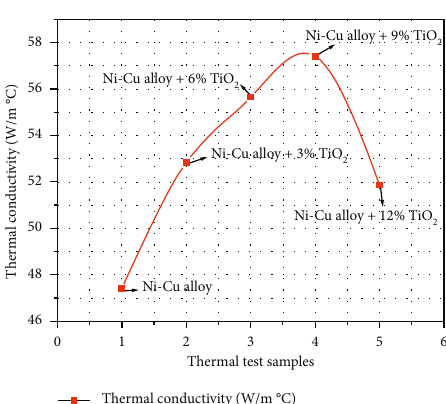
Figure 7: Thermal conductivity of the nanocomposites.